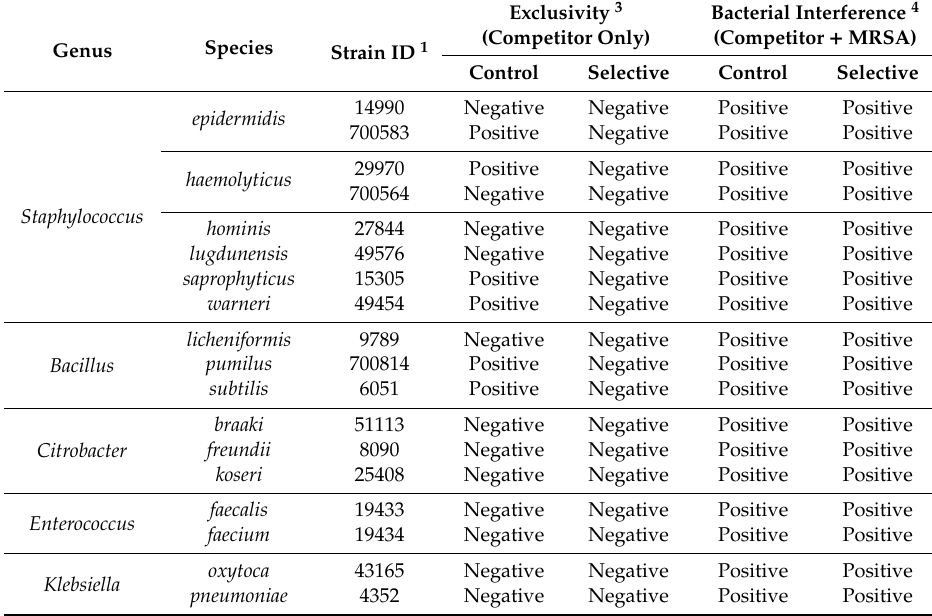
Table 3. In Vitro exclusivity and assay performance with bacterial